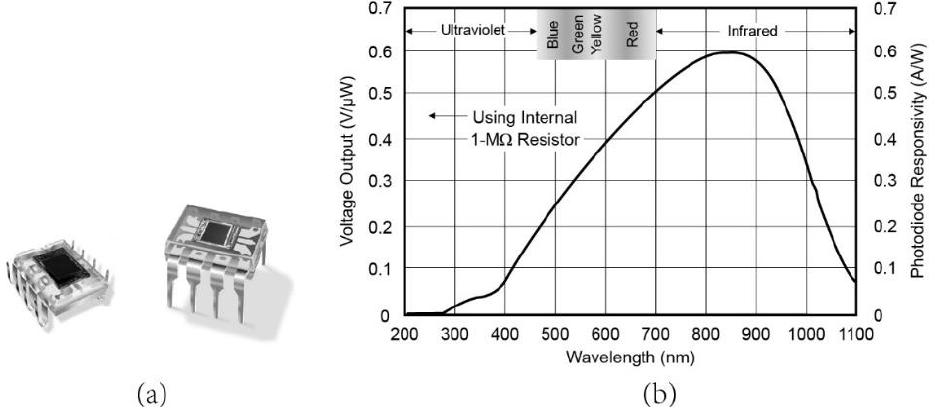
Figure 5. ( a ) OPT101; ( b ) The spectral responsivity. (Reproduced from Texas Instruments’ datasheet of the OPT101).